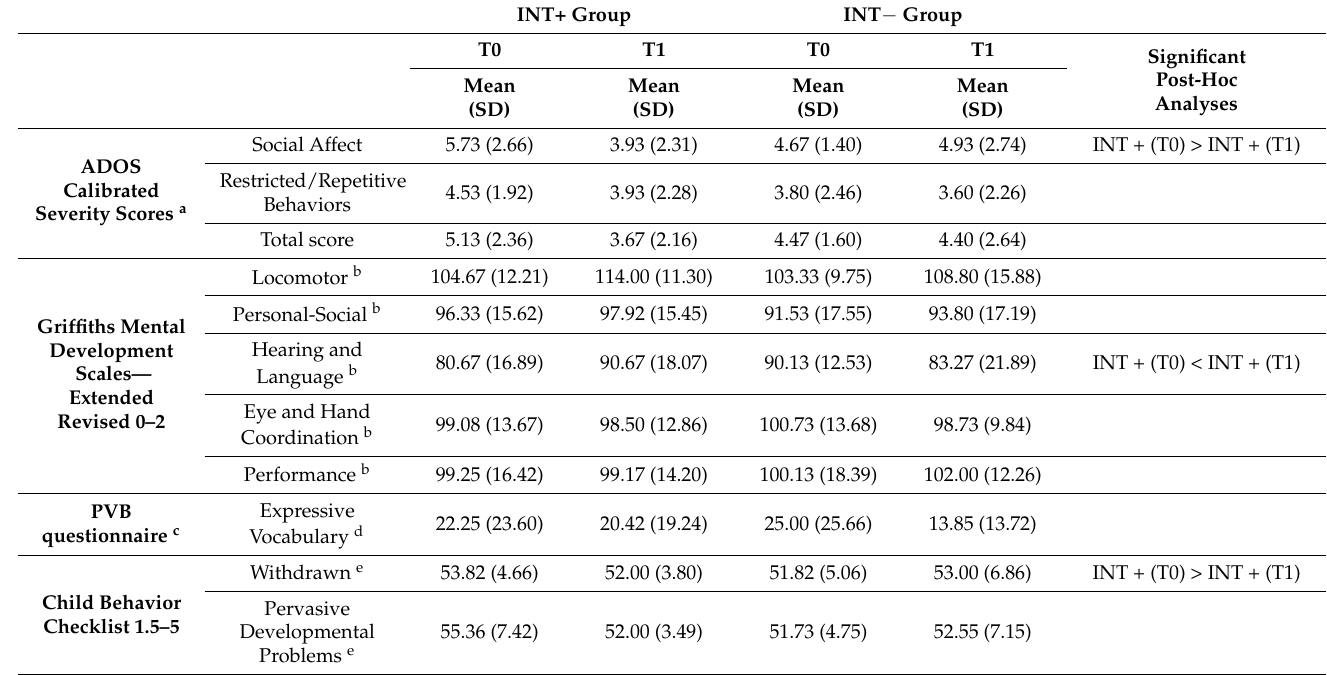
Table 2. Descriptive statistics of the two groups (INT+, INT − ) at T0 and